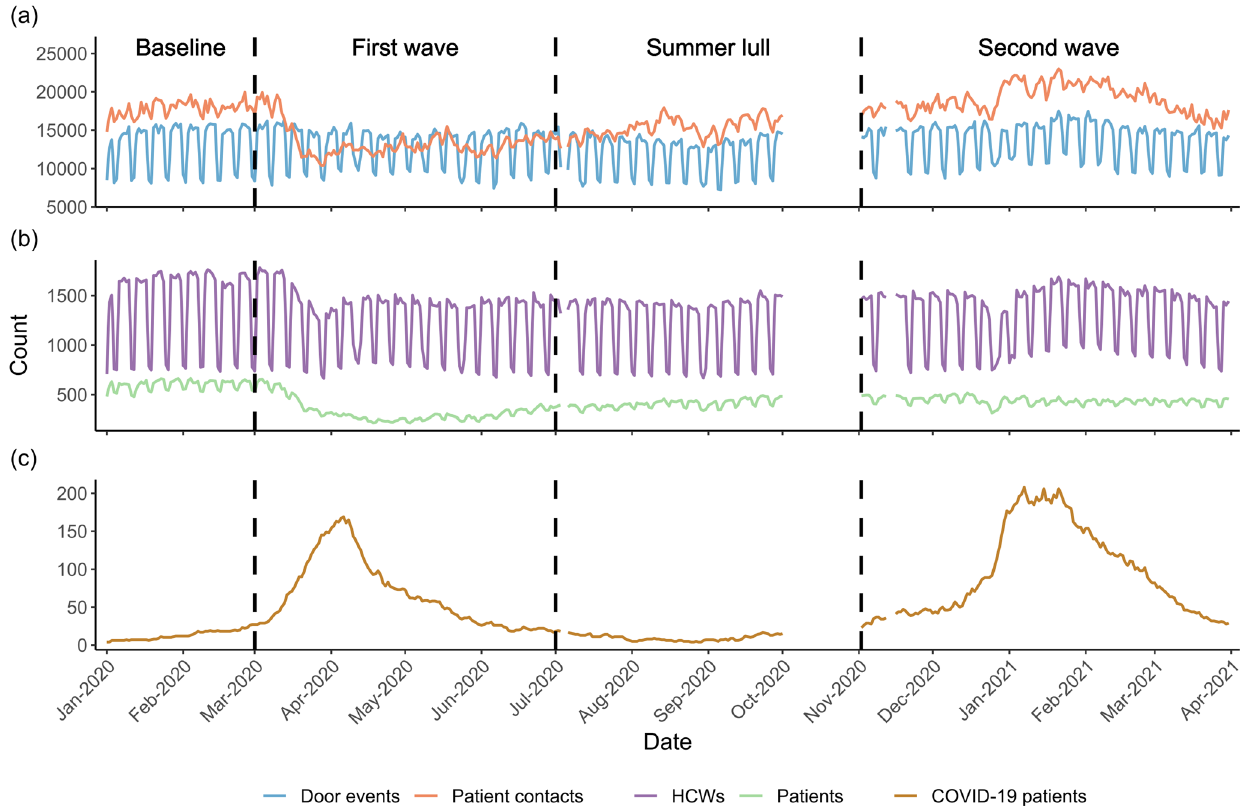
Fig. 1 Daily counts for indicators of healthcare worker behaviour, staf fi ng levels and patient numbers in the Tower building of University College London hospital during the fi rst year of the COVID-19 pandemic. Plot ( a ) shows the activity of healthcare workers in the hospital as characterised by the daily count of door events (blue line) and patient contacts (red line) logged in routinely collected electronic data sources. Plot ( b ) shows daily counts for the number of healthcare workers (purple line) and patients (green line) identi fi ed in the data. Plot ( c ) shows the number of COVID-19 patients in the hospital (gold line), which was used to determine the different stages of the pandemic. For each plot the vertical black dashed lines indicate the start and stop points for each stage of the pandemic; Baseline (pre-pandemic), fi rst wave, summer lull and second wave. Data for October 2020 was not